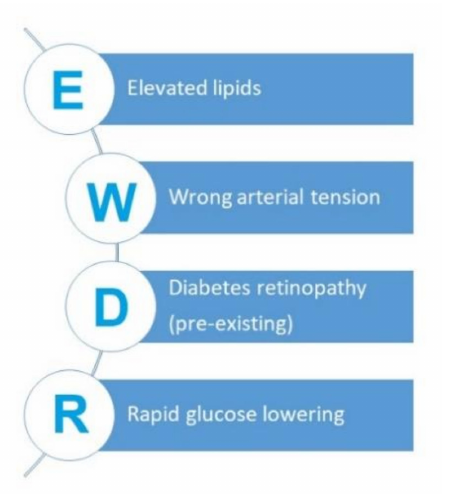
Figure 1. Modifiable risk factors for the development of EWDR- Early Worsening of Diabetic Retinopathy. Prevention of EWDR comprises patient education and step-by-step implementa- tion of metabolic goals in diabetes treatment, which are related to glycemia, lipids, or blood pressure. When diabetes treatment is intensified, more frequent visual assess- ment is recommended—every 3–6 months, depending on the baseline fundus